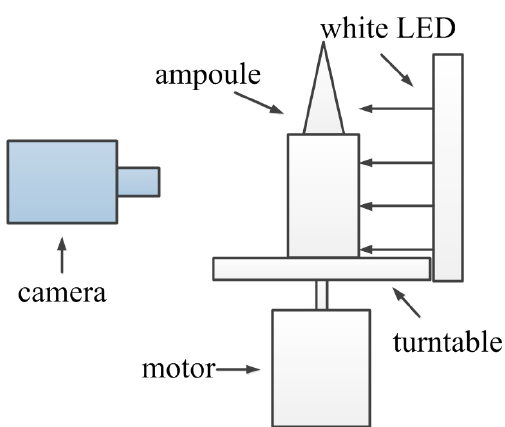
Figure 1. Framework of the detection